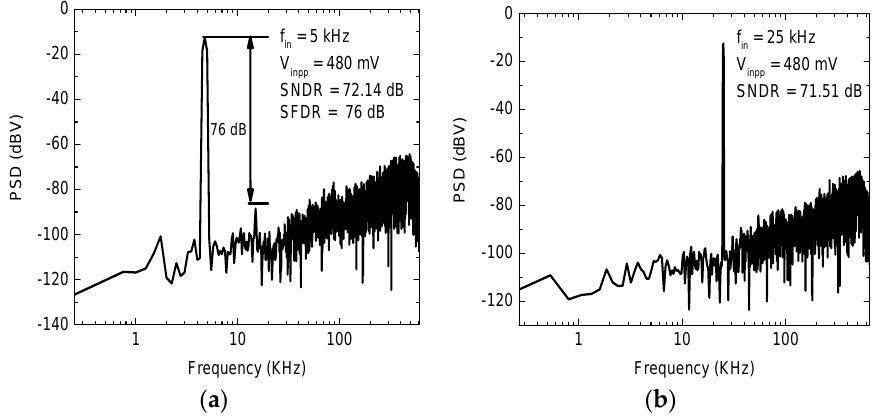
Figure 26. Power spectrum density versus frequency at ( a ) 5 kHz; ( b ) 25 kHz.